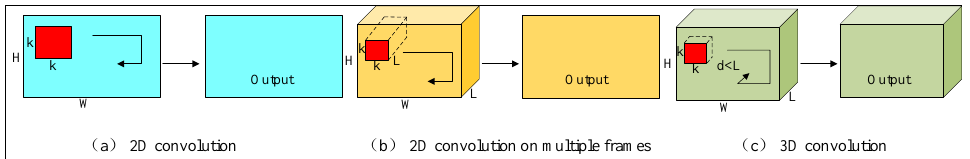
Figure 2. Schematic diagram of 2D and 3D convolutional neural network. ( a ) Applying 2D convo- lution on an image results in an image; ( b ) Applying 2D convolution on a video volume(multiple frames as multiple channels) also results in an image; ( c ) Applying 3D convolution on a video volume results in another volume, preserving temporal information of the input